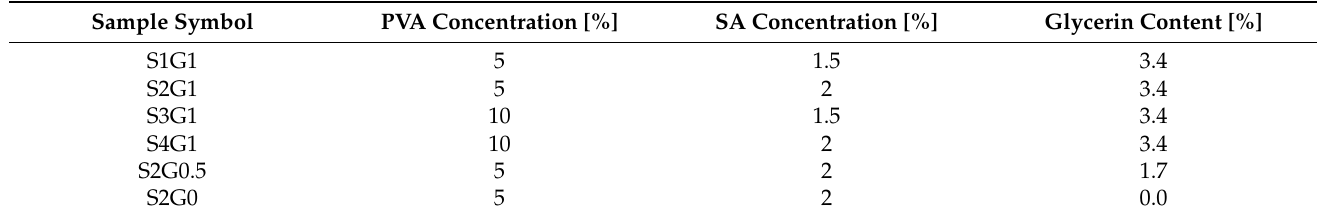
Table 4. Composition of SA/PVA